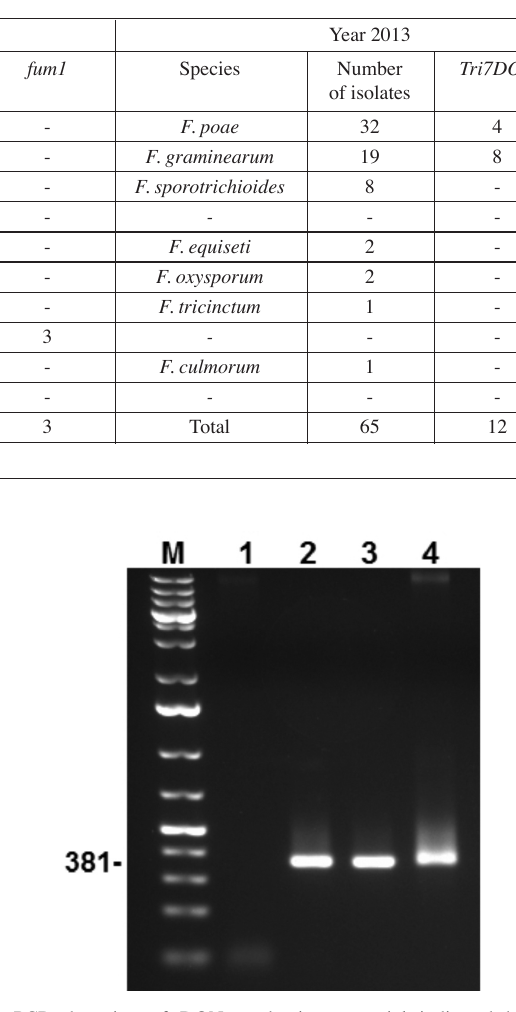
Fig. 2: PCR detection of DON production potential indicated by the presence of Tri7DON marker Tri7F/Tri7DONR. M – DNA size marker GeneRuler DNA Ladder Mix (ThermoScientific, Canada); 1 – negatively identified presence of Tri7DON marker; 2, 3, 4 – positively identified presence of Tri7DON marker. conducted analysis allowed to determine which of the